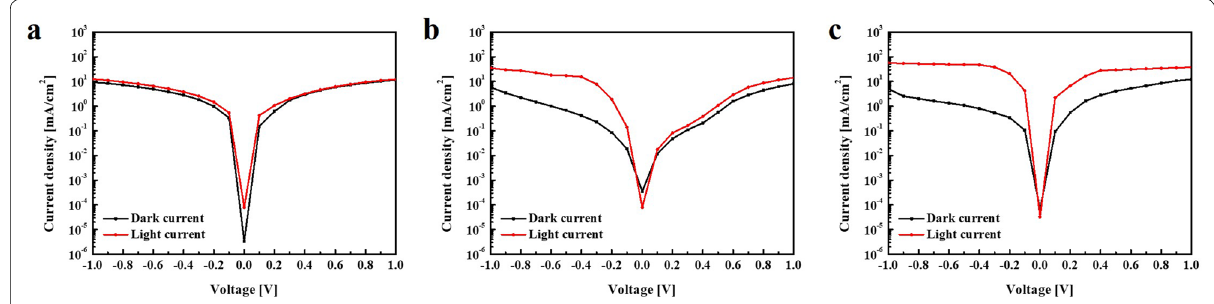
Fig. 5 Current density–voltage ( J ‑ V ) characteristics of fabricated SWIR photodetectors. a SWIR PD1, b SWIR PD2, and c SWIR PD3